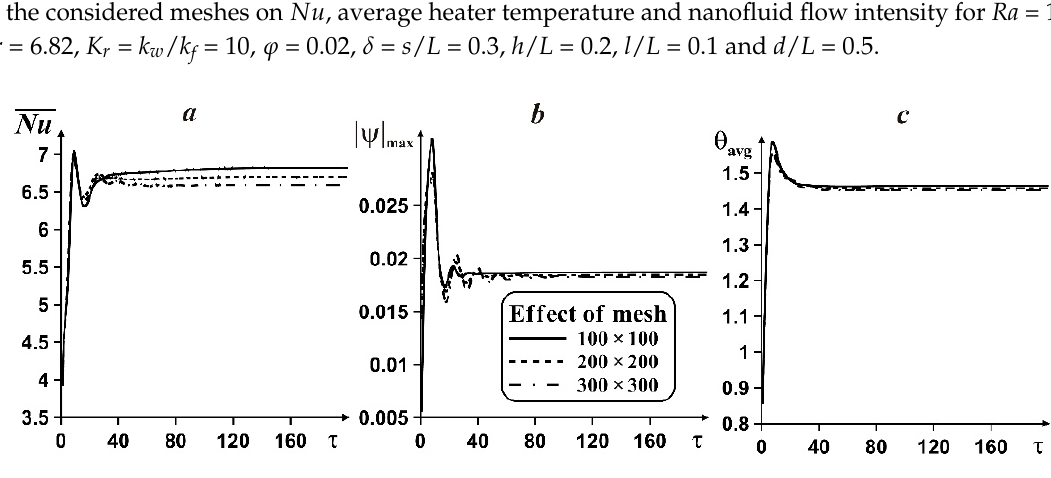
Figure 2. Behavior of the average Nusselt number ( a ), nanoliquid flow rate ( b ) and average heater temperature ( c ) with the non-dimensional time and grid characteristics.